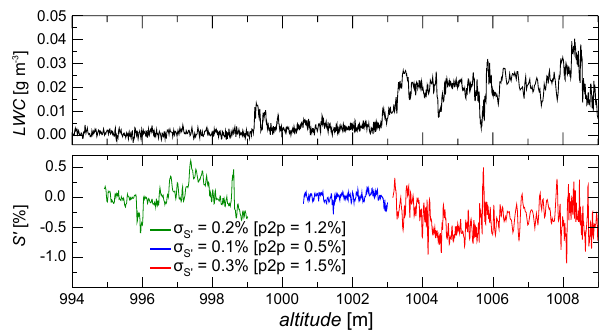
Fig. 9. Liquid water content (LWC) and linearly detrended satu- ration fluctuations ( S 0 ) as function of the altitude during the first ascent when ACTOS touched the cloud base of the SC